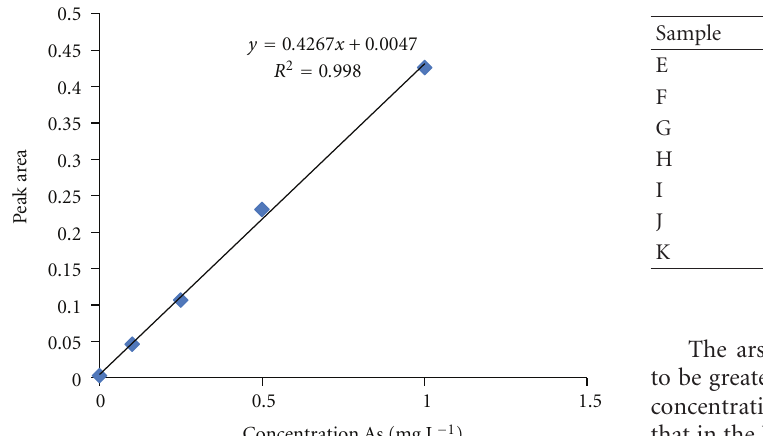
Table 6: Mass balance data for arsenic